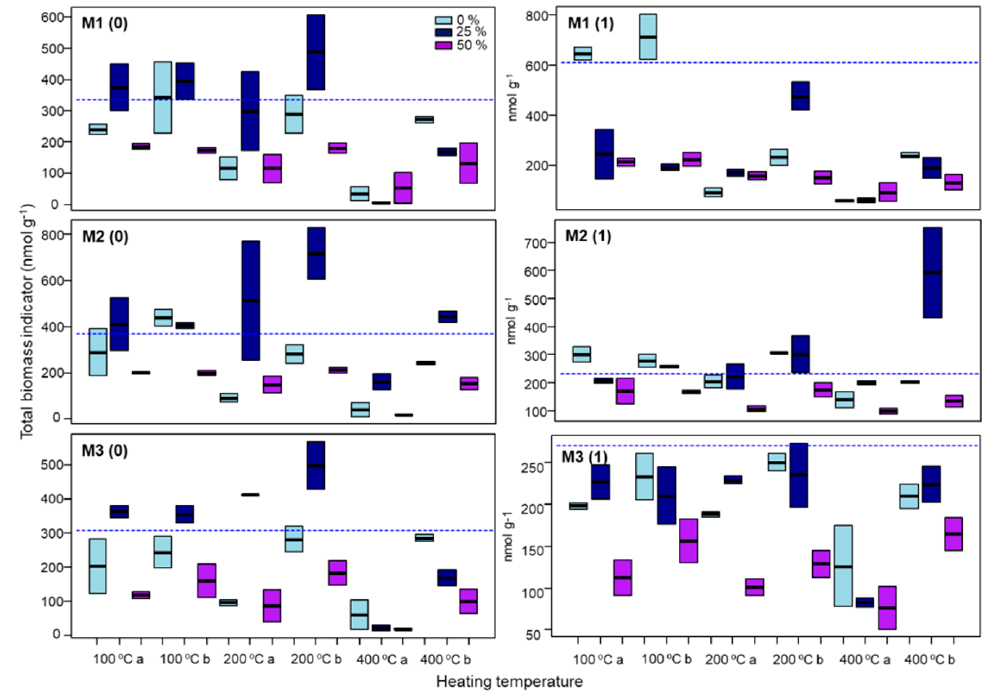
Figure 4. Total microbial biomass (sum of all PLFA) in nmol g − 1, immediately (0) and 1 month (1) after the heating of the heated samples (0%), and samples rewetted to 25 and 50% of soil water content before heating at 100, 200 and 400 ◦ C. M1, soil mixture 1; M2, soil mixture 2; M3, soil mixture 3; a, soil layer (0–2 cm); b, soil layer (2–4 cm). The boxes represent the interquartile range and the horizontal lines within those boxes are the median. The dash line represents the intercept of the GLM